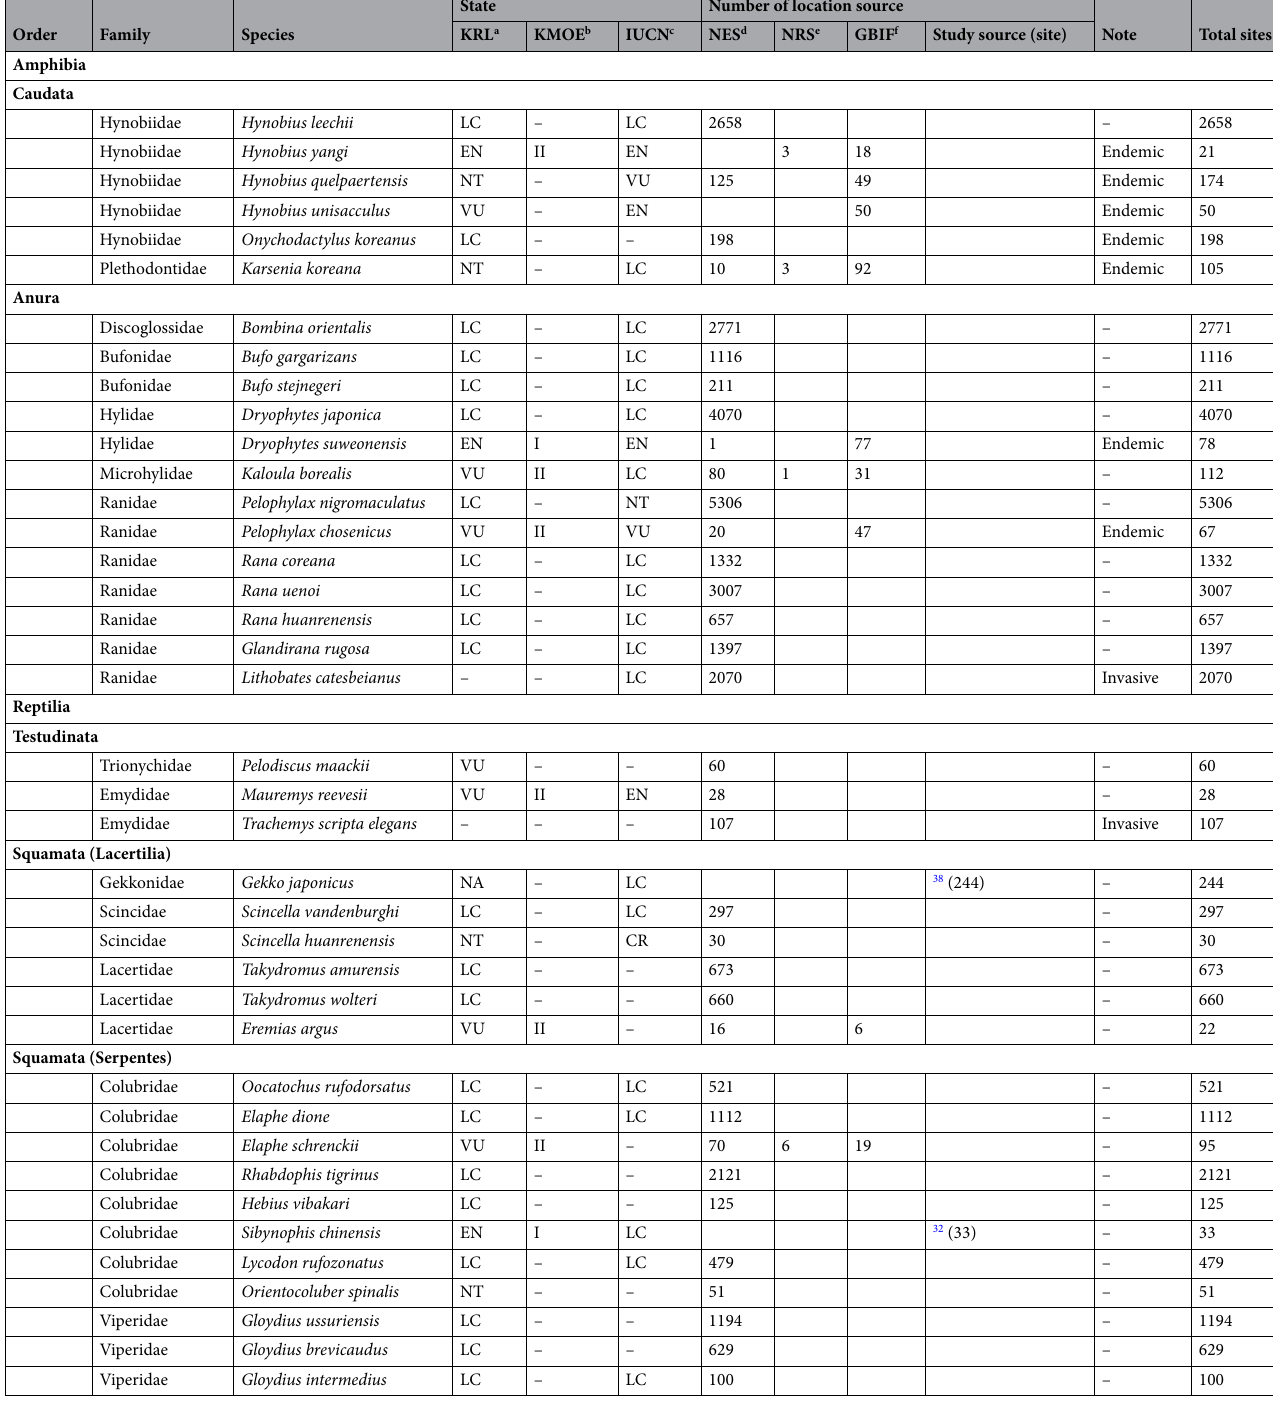
Table 1. The 19 amphibian species and 20 reptile species included in this study, along with the number of collection sites used for Maxent modeling. a Status according to the Koran Red List of Threatened Species (KRL), b Status of Endangered Species designated by the KMOE (Korea Ministry of Environment). c Location source of Nationwide Environmental Study (NES), d Location source of Natural Resource Study (NRS), e Location source of Global Biodiversity Information Facility